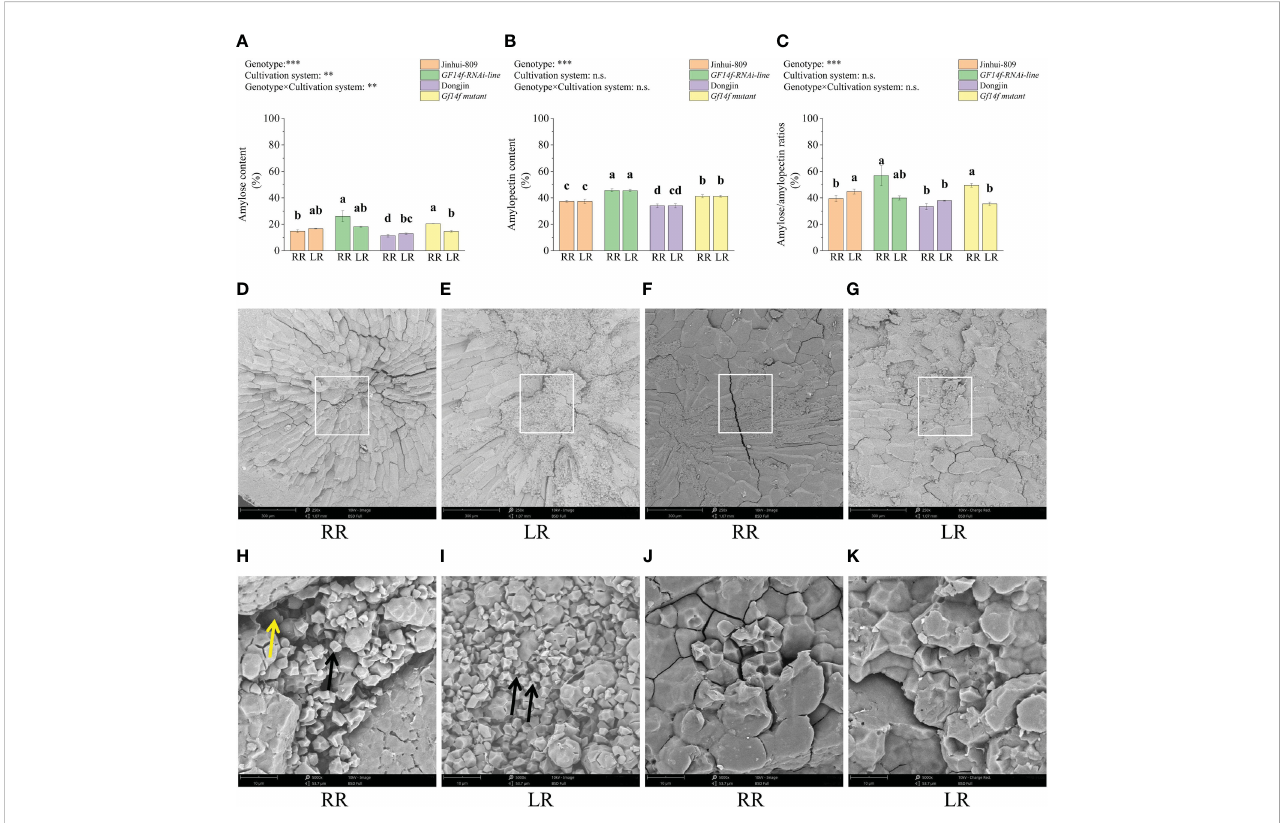
FIGURE 3 Comparisons in starch composition and scanning electron microscope observation in endosperm structure. (A – C) : Amylose, amylopectin and amylose/ amylopectin ratio that varied between GF14f-RNAi line, GF14f mutant and their WT; (D – K) : Scanning electron microscopy images of the starch granules in endosperm. Positions marked by rectangles in the middle bellies of the endosperm. Scale bars: 250 times magni fi cention (top); 5000 times magni fi cention (bottom). Black arrows point loosened starch granules and yellow arrows point the loss of compositional parts of starch. MR, RR and LR represent early-season rice, ratoon rice and late-season rice,